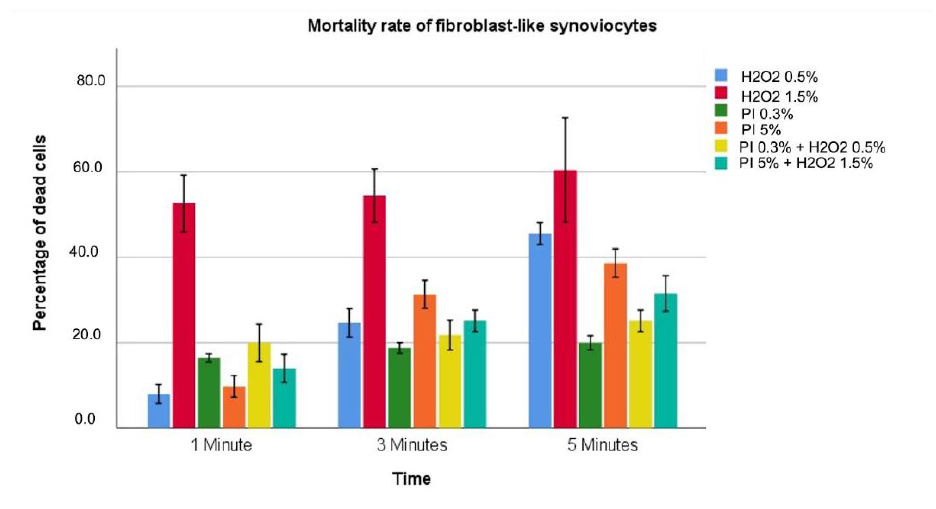
Figure 3. Different colors indicate different solutions. The height indicates the percentage of dead cells for the highlighted solution at that specific exposure time associated with